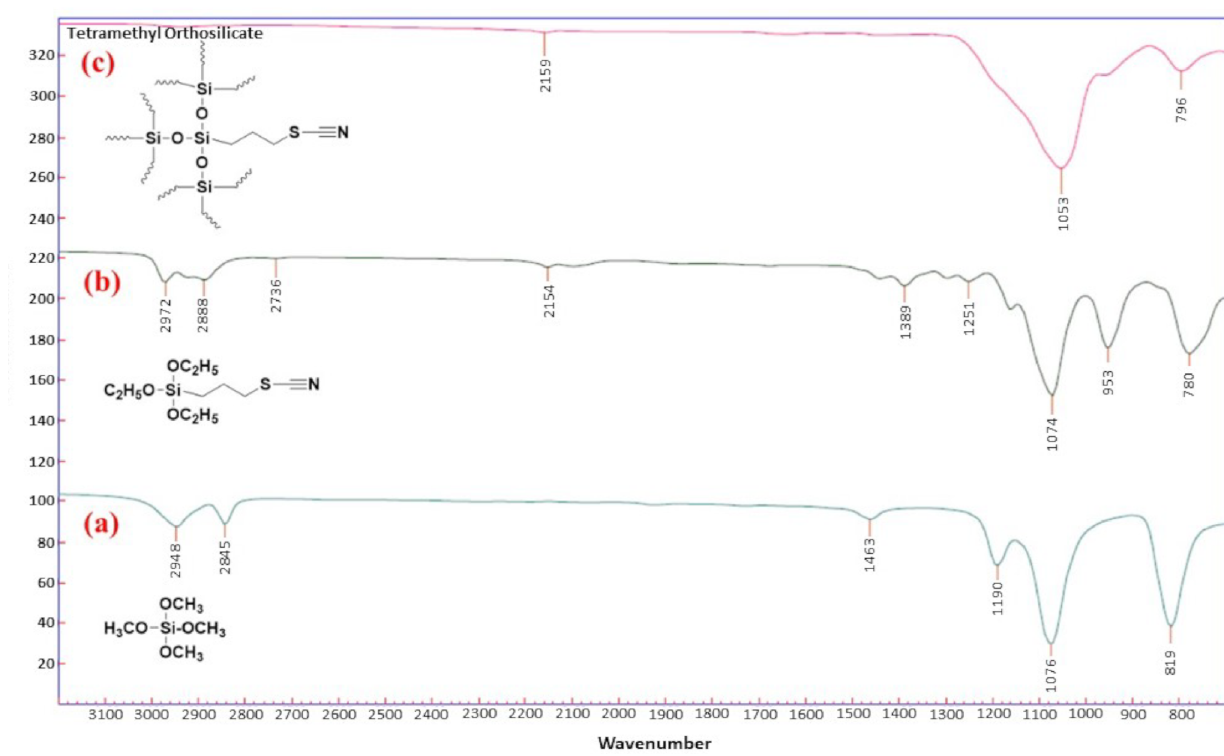
Figure 1. FT-IR spectra of ( a ) tetramethyl orthosilicate (TMOS); ( b ) 3-thiocyanatopropyl triethoxysilane; and ( c ) 3- thiocyanatopropyl-functionalized sol-gel silica